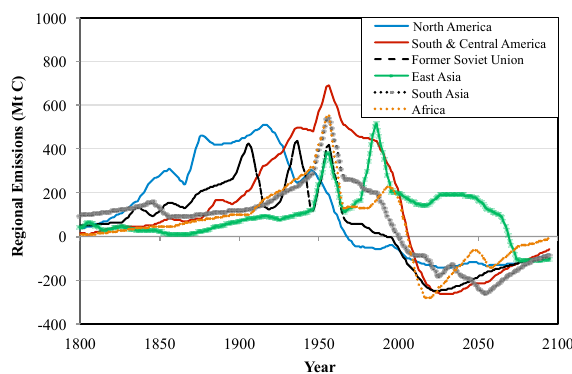
Fig. 2. Annual land-use change emissions (MtCyr − 1 ) by region from the G-Carbon model (smoothed by 9yr